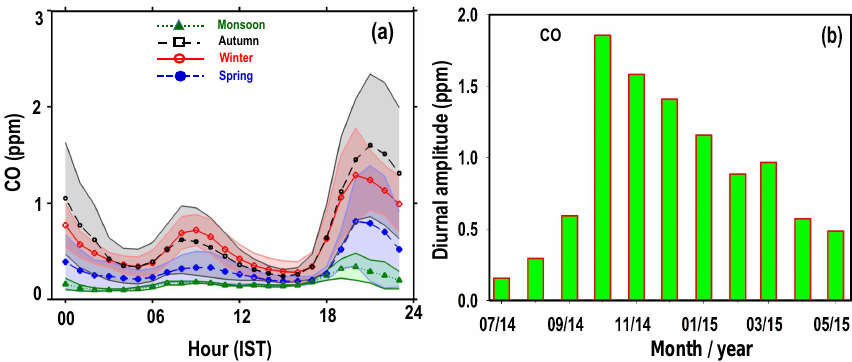
Figure 6. (a) Diurnal variation of CO over Ahmedabad during all four seasons. (b) Monthly variation of the diurnal amplitude of CO.